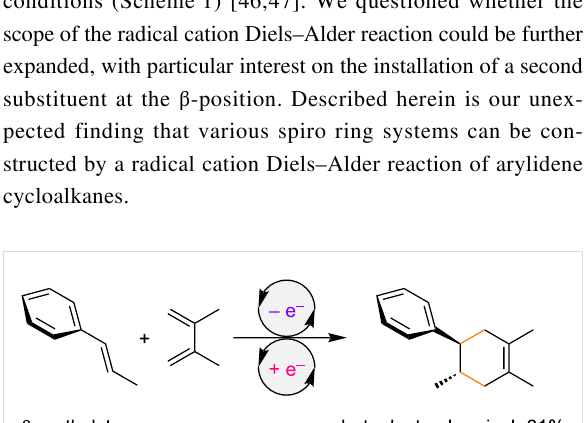
chlorate (LiClO 4 )/nitromethane (CH 3 NO 2 ) solution [36-44].